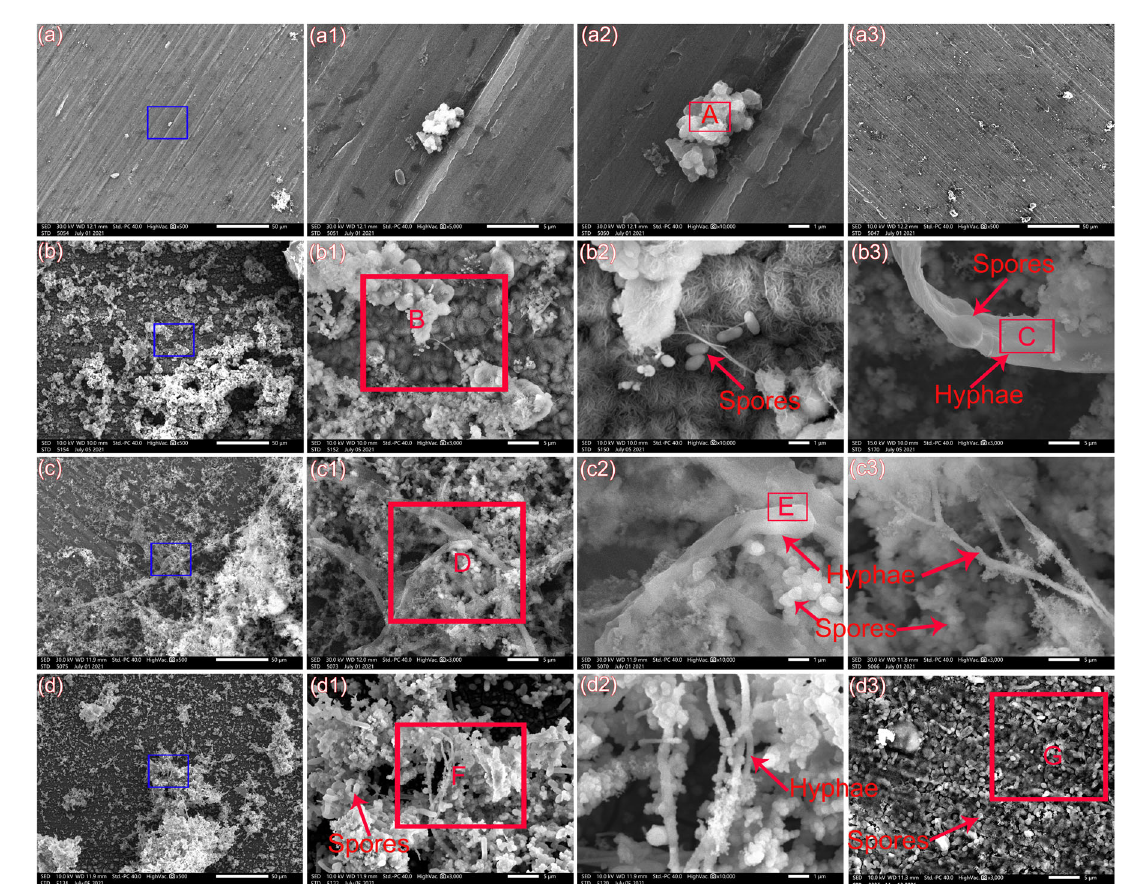
Fig. 1 SEM images of surface fi lms with different initial spore concentrations of A . terreus with continued organic carbon starvation. a control, b 10 4 spores mL − 1 , c 10 6 spores mL − 1 , d 10 8 spores mL − 1 . Images ( a 1), ( b 1), ( c 1), and ( d 1) are the part enlarge of images ( a ), ( b ), ( c ), and ( d ) corresponding to the blue square area, respectively. Images ( a 2), ( b 2), ( c 2), and ( d 2) are the part enlarge of images ( a 1), ( b 1), ( c 1), and ( d 1), respectively. Images ( a 3), ( b 3), ( c 3), and ( d 3) are the different position of surface fi lms corresponding to the control, 10 4 spores mL − 1 , 10 6 spores mL − 1 , and 10 8 spores mL − 1 ,